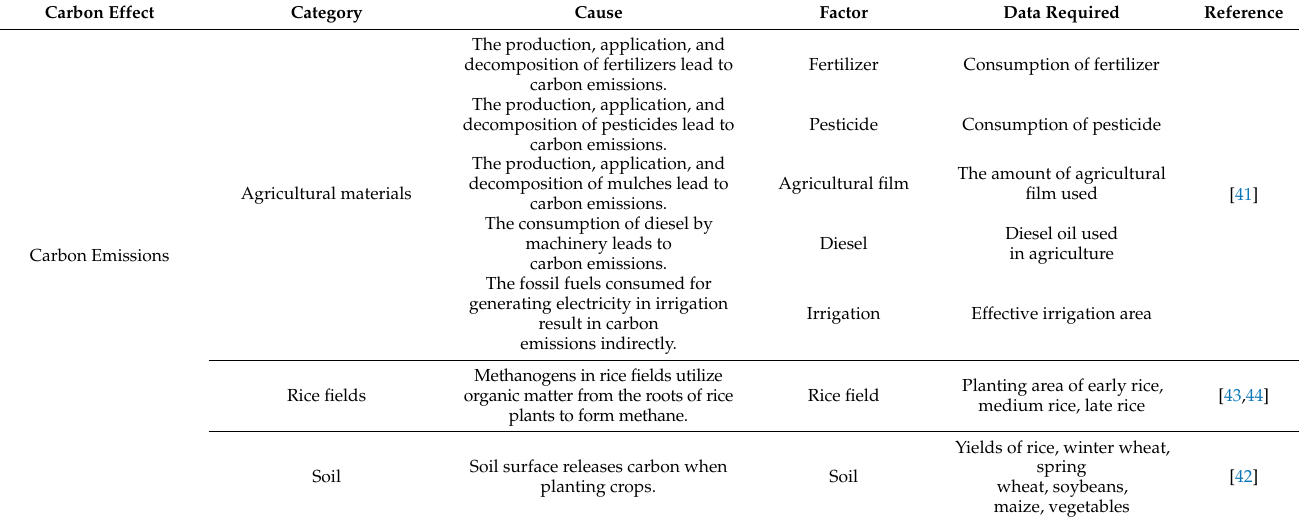
Table 1. Agricultural carbon emissions and